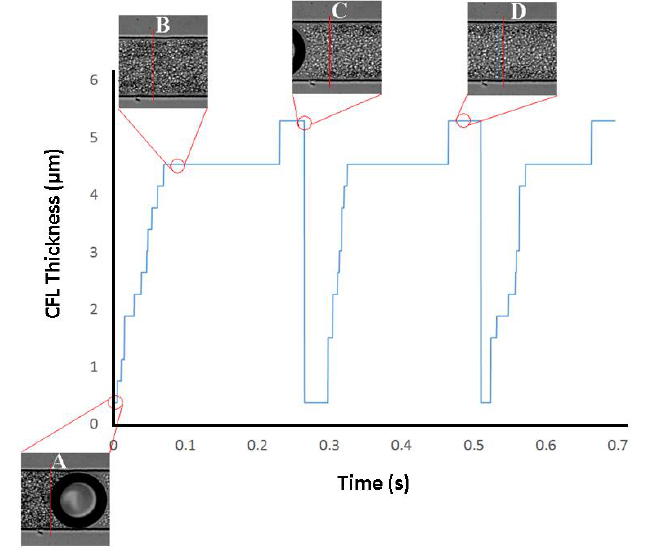
Figure 5. CFL thickness over time in the top wall of the channel.